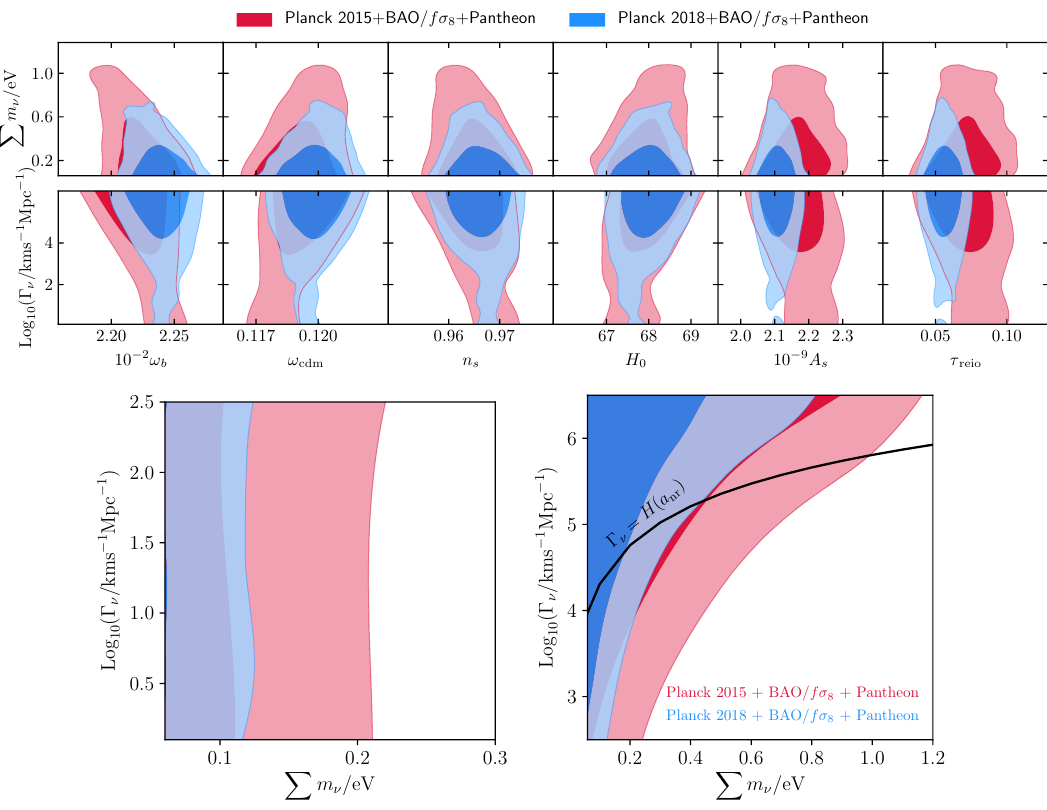
Figure 6 . 2D posterior distribution of the decaying neutrino model reconstructed from the analysis of BAO + FS + Pantheon together with either Planck 2015 or Planck 2018 data. In the top panel, we show the correlation with other cosmological